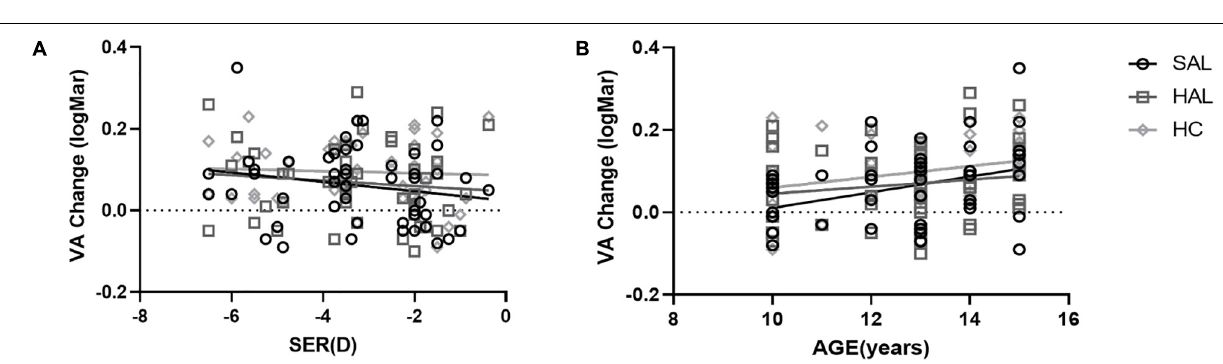
FIGURE 8 | Plots of the relative changes in visual acuity (logMAR) of HAL, SAL, and HC compared to SVL as a function of SER (A) and age (B) for all subjects ( N = 50). The lines correspond to linear regressions. Age was significantly correlated to VA changes for SAL and HC. All other correlations were not